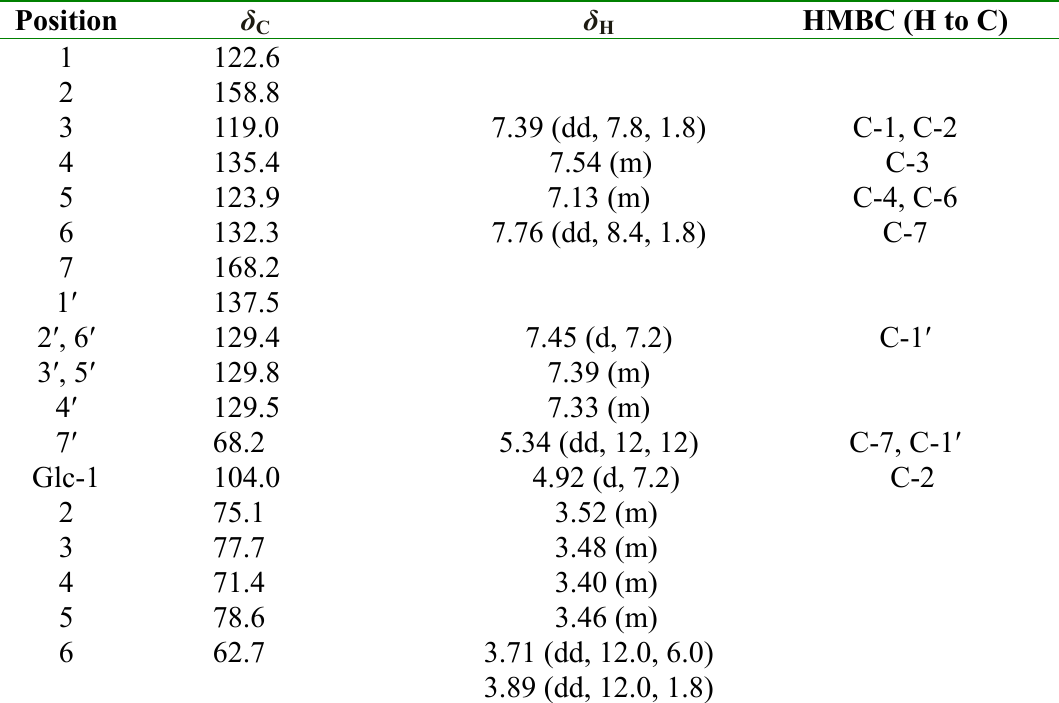
OD ( δ in ppm, J in 3